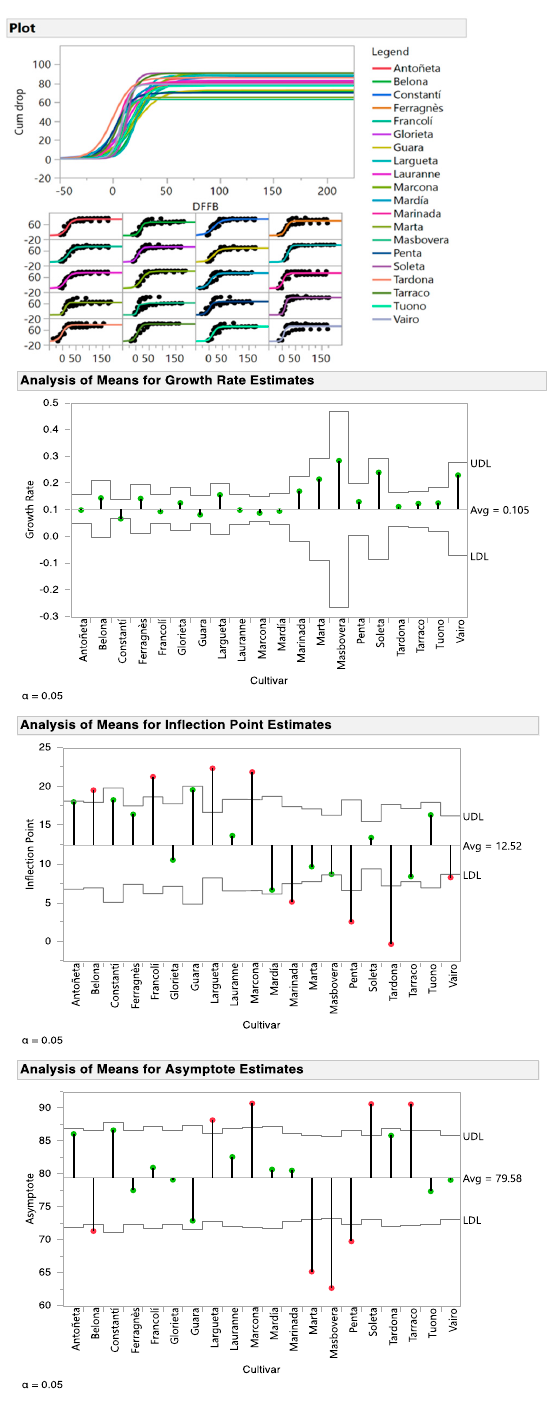
Figure 3. Fitted curves and parameter comparison for the logistic three-parameter models fitted to describe the relationship from bud break until 180 days after full bloom between cumulative fruit drop (%) and days from full bloom (DFFB) for ‘Antoñeta’, ‘Belona’, ‘Constantí’, ‘Ferragnès’, ‘Francolí’, ‘Glorieta’, ‘Guara’, ‘Lauranne’, ‘Largueta’, ‘Marcona’, ‘Mardía’, ‘Marinada’, ‘Marta’, ‘Masbovera’, ‘Penta’, ‘Soleta’, ‘Tardona’, ‘Tarraco’, ‘Tuono’, and ‘Vairo’ almond cultivars at Les Borges Blanques, Spain (P1). Data were recorded during 2015–2017.